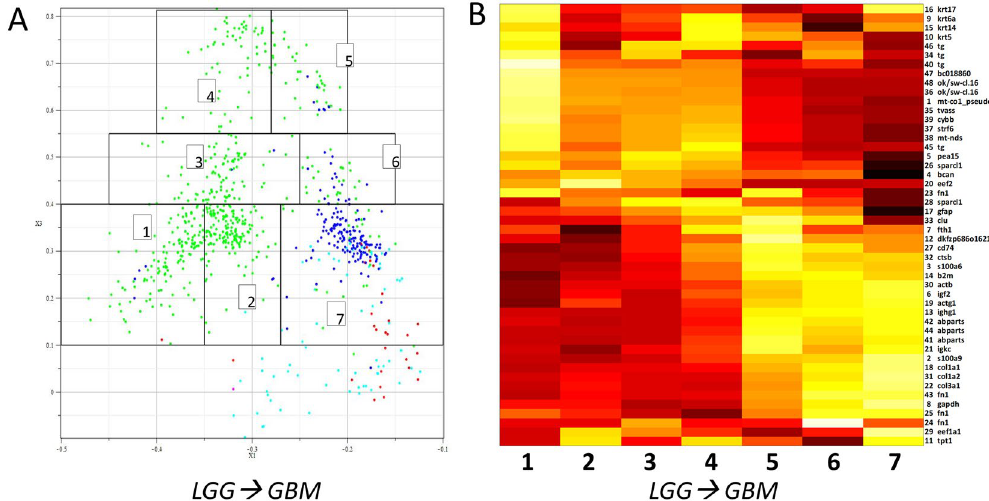
Figure 2. LGG and GBM Samples Create Complex “Brain Arch” Structure in DQC Evolutions. ( A ) The 48 “core transcript” subset of LGG (green) and GBM (blue) samples produces an arch in DQC. Segmentation of samples within the arch was performed by k-means clustering at frame 56 of the DQC evolution of the 48 transcripts. Each arch group was labeled with a number; ( B ) Average gene expression heatmap of all 48 transcripts along the arch for each position numbered to the left. Yellow is high expression and red is low expression. Locus names (Supplemental Table 1) are shown on the far